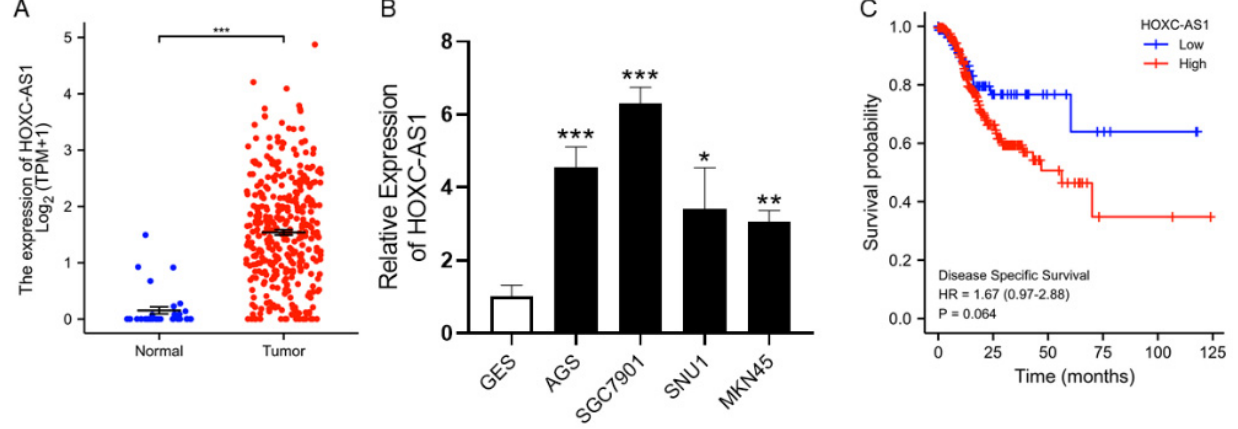
Figure 1. HOXC-AS1 was overexpressed in GC with poor prognosis. ( A ) HOXC-AS1 expression in normal and tumorous gastric tissues from TCGA; ( B ) HOXC-AS1 expression in normal gastric epithelial cells (GES) and GC cell lines (AGS, SGC7901, SNU1 and MKN45) by qRT-PCR; ( C ) Kaplan- Meier analysis for disease specific survival of GC patients based on the expression of HOXC-AS1. * p < 0.05; ** p < 0.01; *** p <